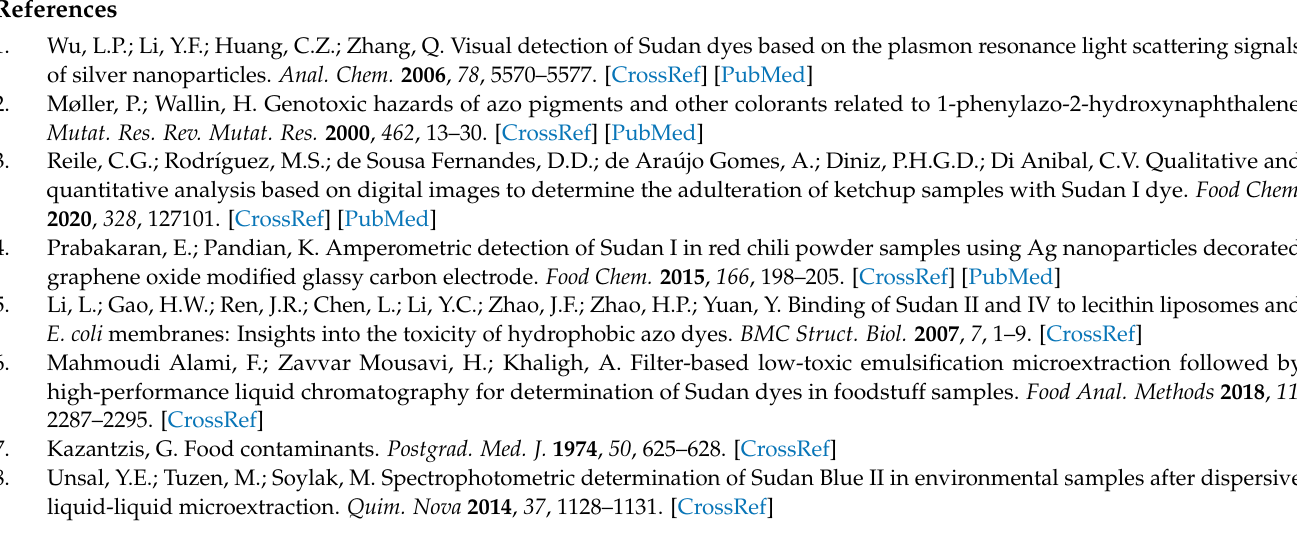
(P500). Figure S2: Raman spectrum of 15PVDF-coHFP. Figure S3: UV-vis DRS on PVDF-coHFP and PVDF-coHFP_TiO 2